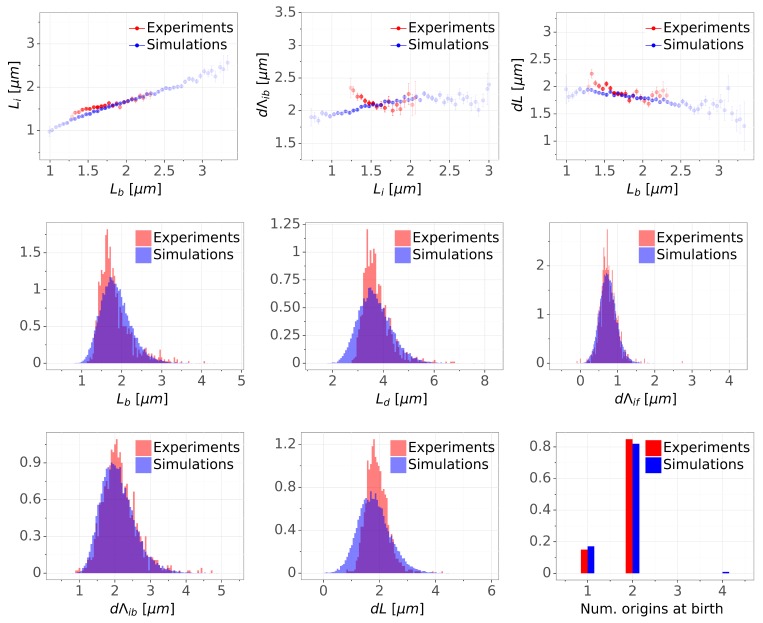
Detailed comparisons of cell cycle variables distributions and correlations between experiments and simulations for M9+glucose condition (with manual origin tracking).The top row shows binned scatter plots of pairs of variables. The transparency degree reflects the density of data on the horizontal axis.